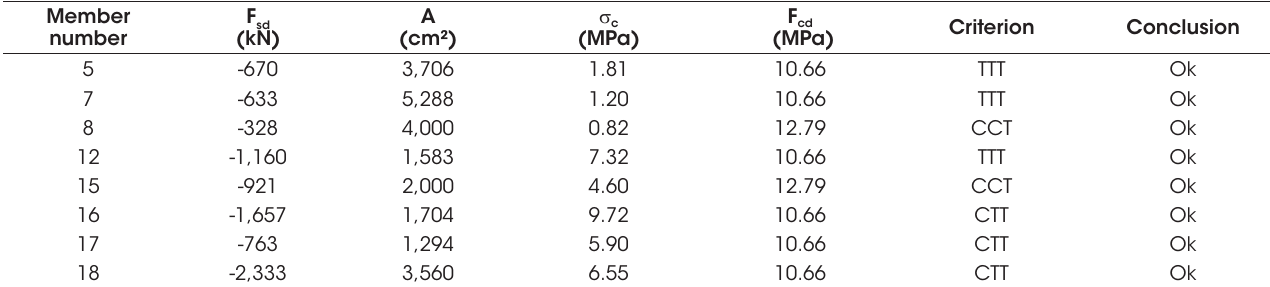
Design of the compression bars of the Example 1